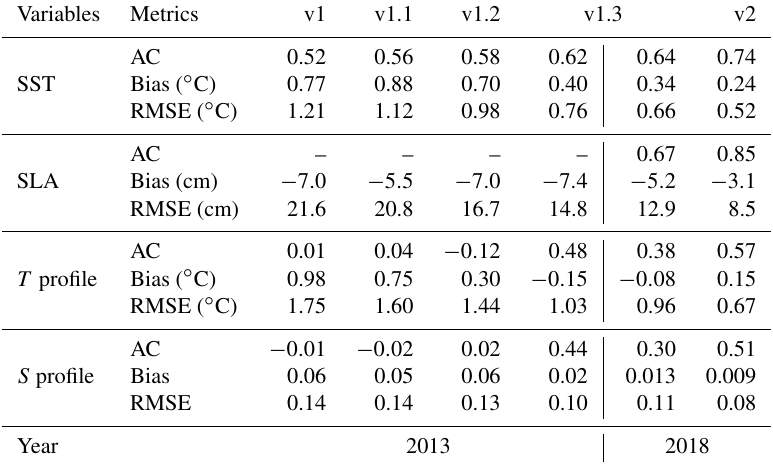
Table 3. Mean values of each metric of the four physical variables for the best estimates of each sub-version ( T denotes temperature, S denotes salinity, AC denotes anomaly